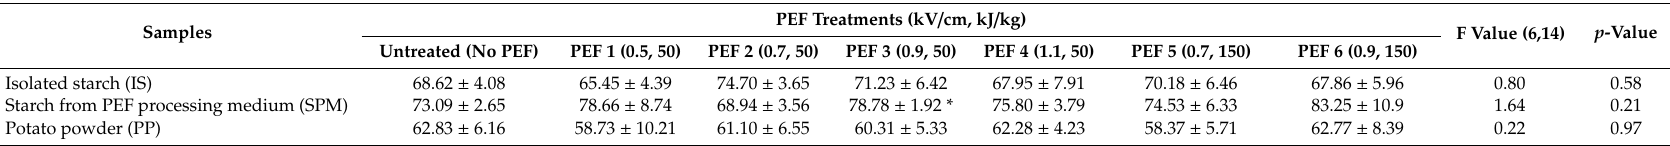
Table 3. Susceptibility, expressed as % ( w / w ) hydrolysed starch, of isolated starch, starch from PEF processing medium, and potato powder from PEF-treated potatoes towards heat-stable α -amylase and amyloglucosidase.